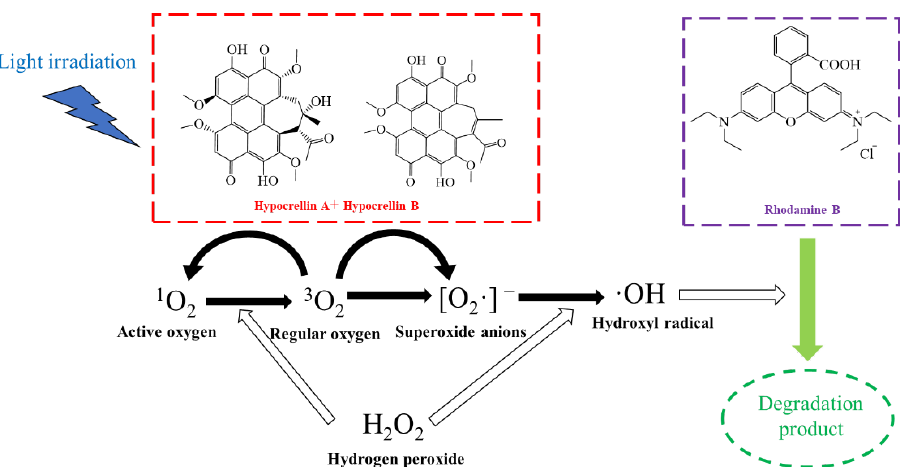
Figure 1. Mechanism for the generation of hydroxyl radicals by the HYPs/H 2 O 2 PAOP.